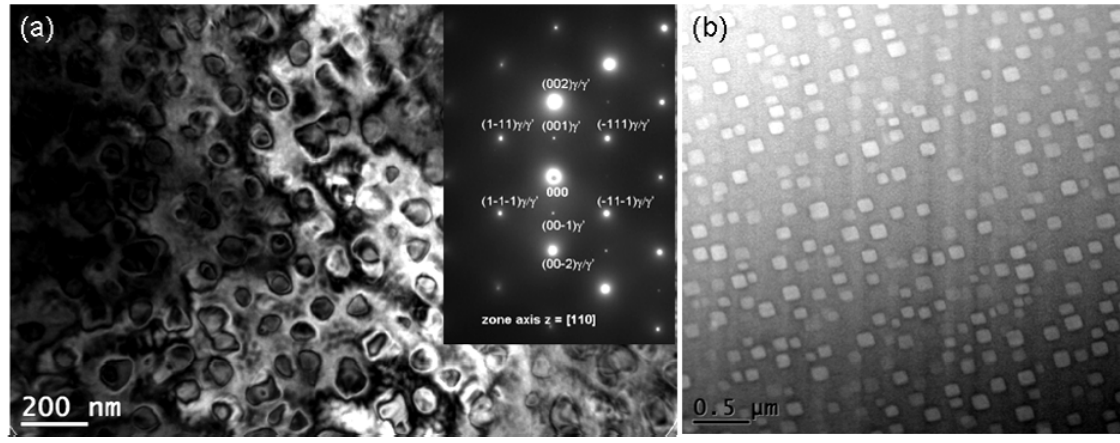
Figure 16. A BF TEM image and selected area electron diffraction pattern for γ / γʹ type microstructure in the as-cast Haynes ® 282 ® superalloy: ( a ) dendrite; and ( b ) interdendritic